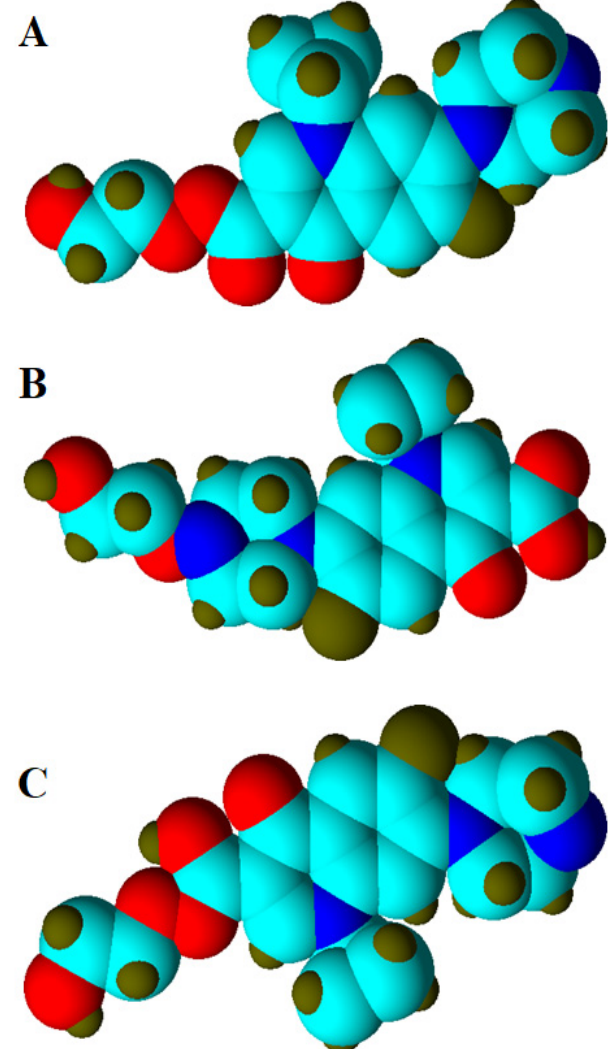
Figure 3. Space-filling chemical models of the AgNP-PEG-CIP (two methylene units,-CH 2 -CH 2 , of the AgNP-PEG-CIP, i.e., AgNP-O-(CH 2 -CH 2 )n-O-CIP)) interactions, showing compacted structures with the OH, NH and C=O sites in close conjugations to the PEG unit: ( A ) –(C=O)-OH-based CIP conjugation, ( B ) piperazinyl NH-based CIP conjugation, ( C ) (HO-)-C=O-based CIP conjugation—the AgNPs are omitted from the space-filled models.